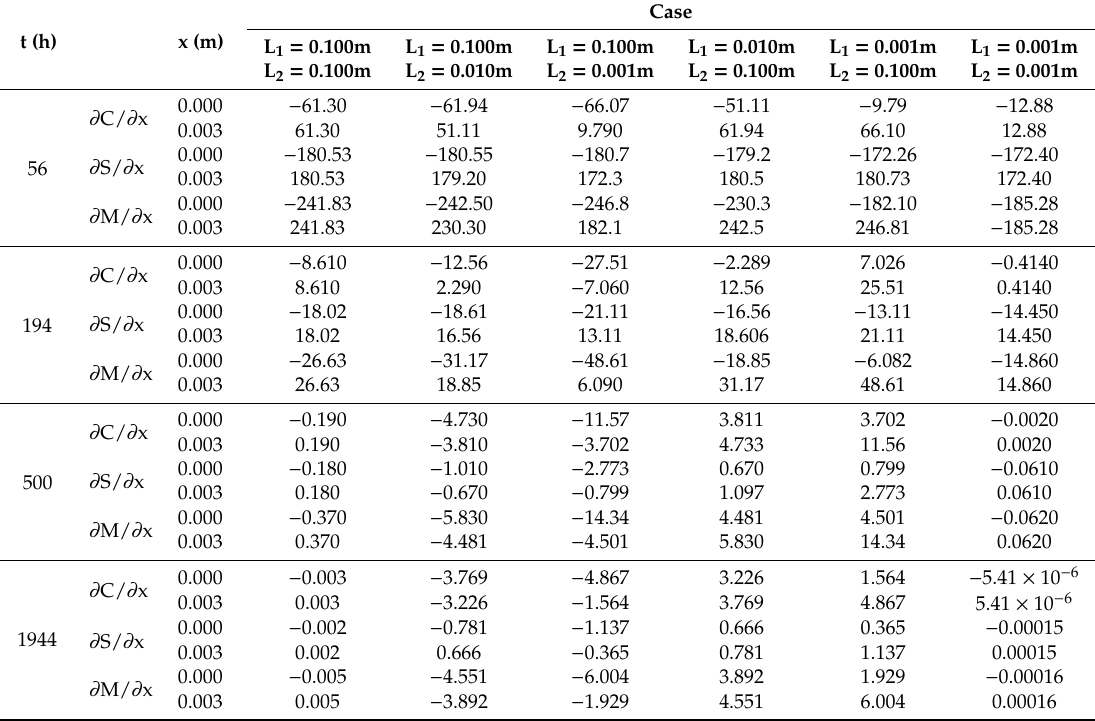
Table 2. Values for the concentration gradients of the free and bound water molecules and the local moisture content at the surface of the material for each simulated